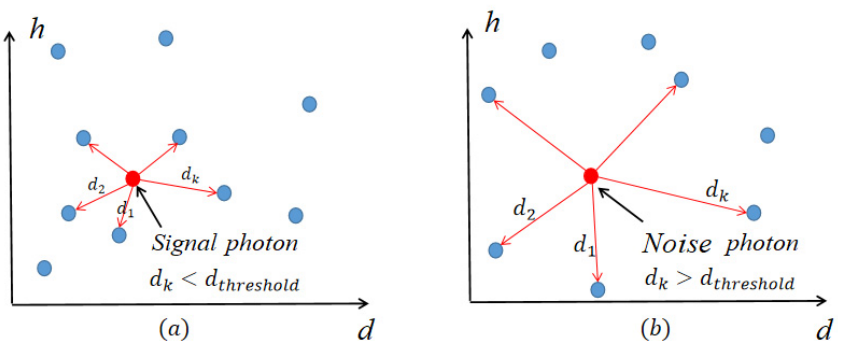
Figure 1. Schematic diagram of KNN-based denoising. ( a ) Schematic diagram of the distribution of the signal photon and its k nearest neighbors. ( b ) Schematic diagram of the distribution of the noise photon and its k nearest neighbors